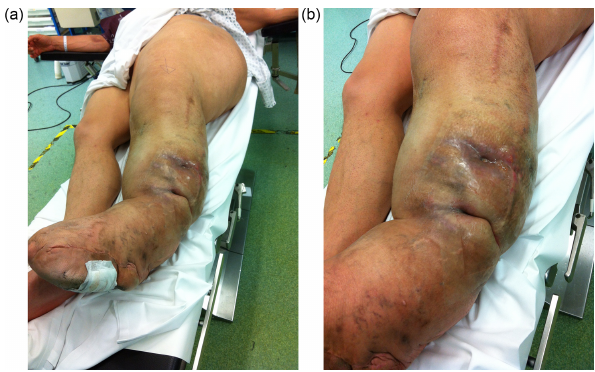
Figure 1. The left leg has the typical features of macrodystrophia lipomatosa, affecting the whole limb and hemipelvis (a) . The pa- tient presented with two draining sinuses in an area of indurated skin (b) .